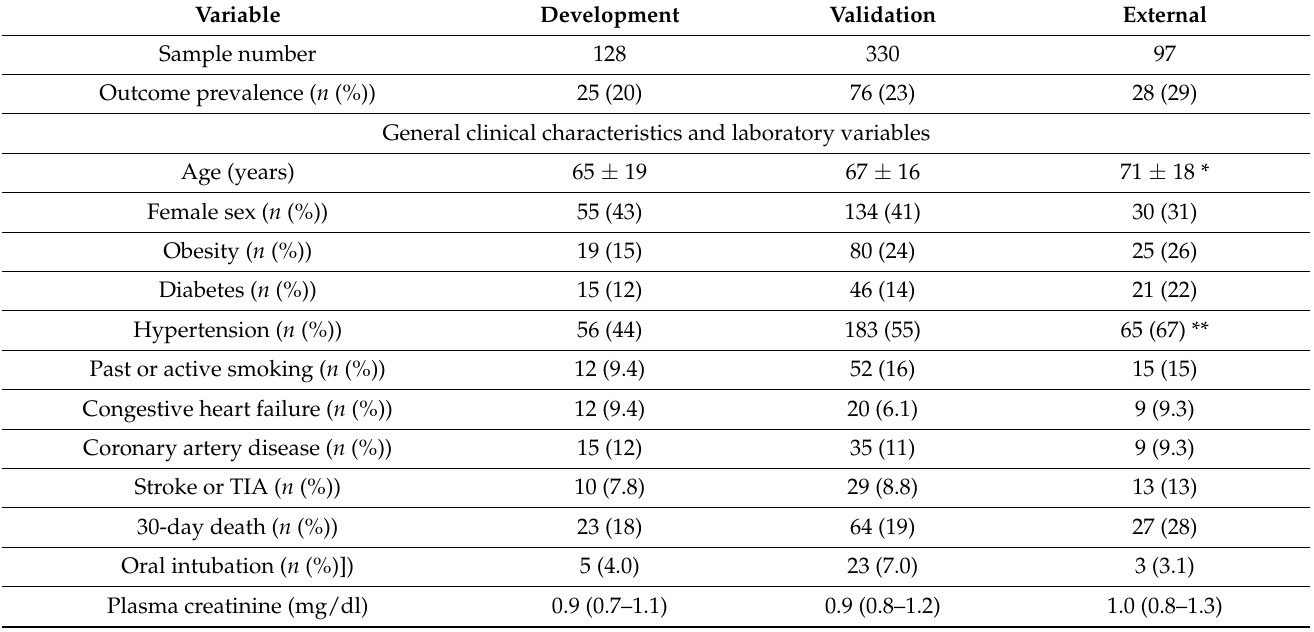
Table 3. Comparison of validation and external cohort variables with those of the development